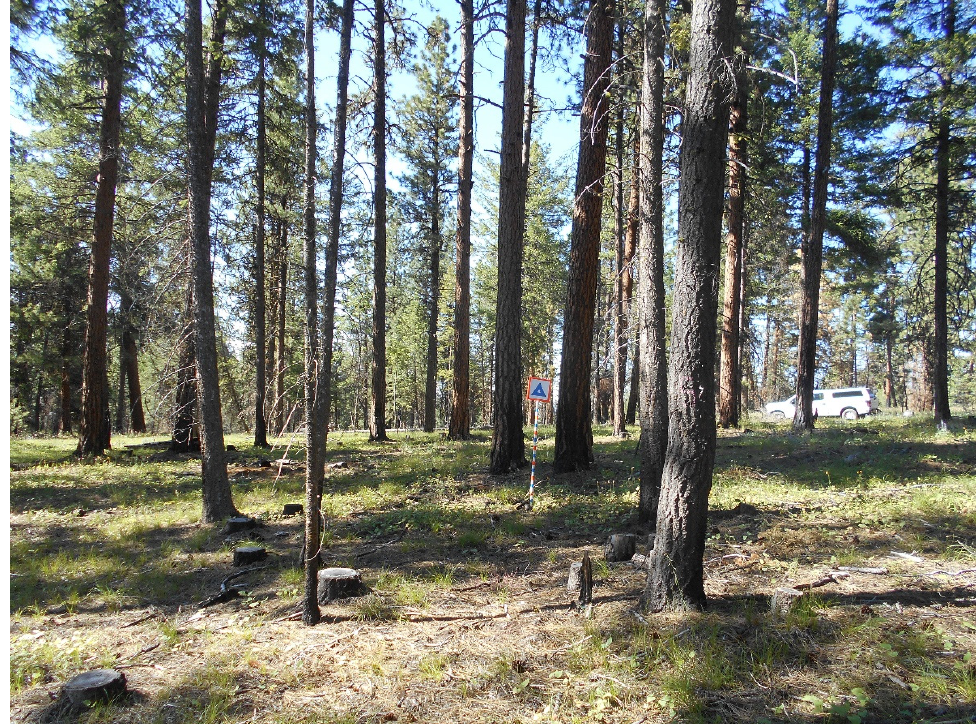
Figure 12. An example of mixed-conifer thin/burn treatment in eastern Oregon, USA. Stumps show where smaller trees were removed. Surface fuels are relatively sparse, vegetation is low and re-growing, and CBH is elevated above the ground.